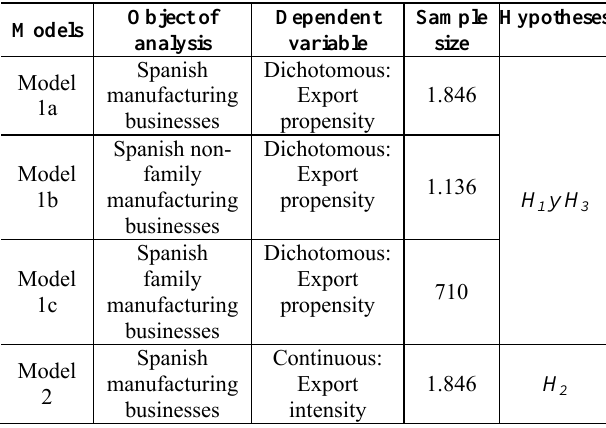
Table 5: Models under